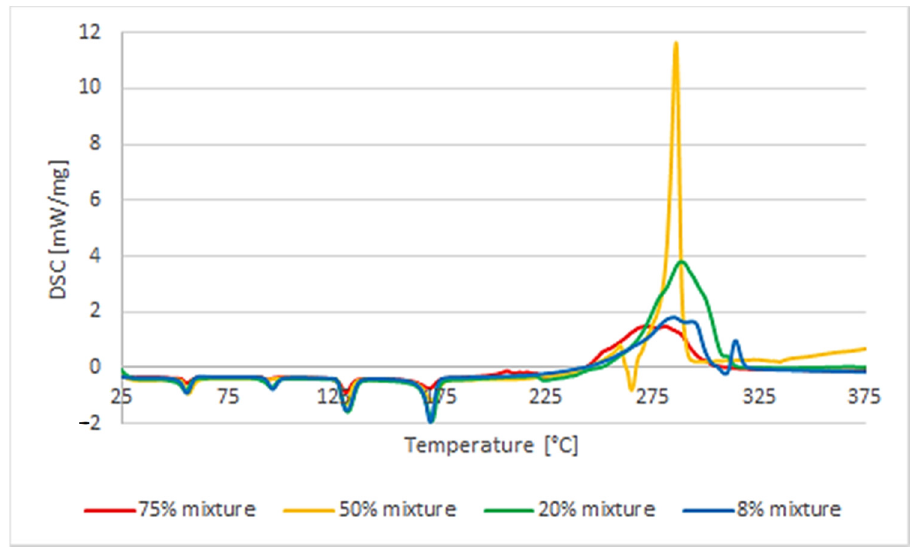
Figure 7. DSC analysis of AN and PS mixture composition influence on their thermal properties, heat rate 10 °C/min.